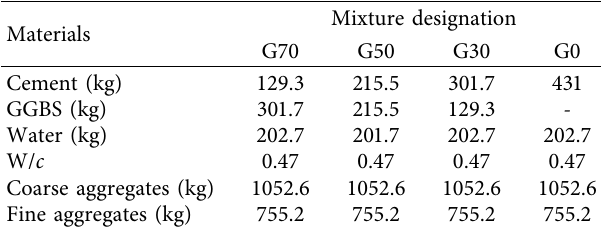
Table 2: Mixing proportions of concrete samples per cubic